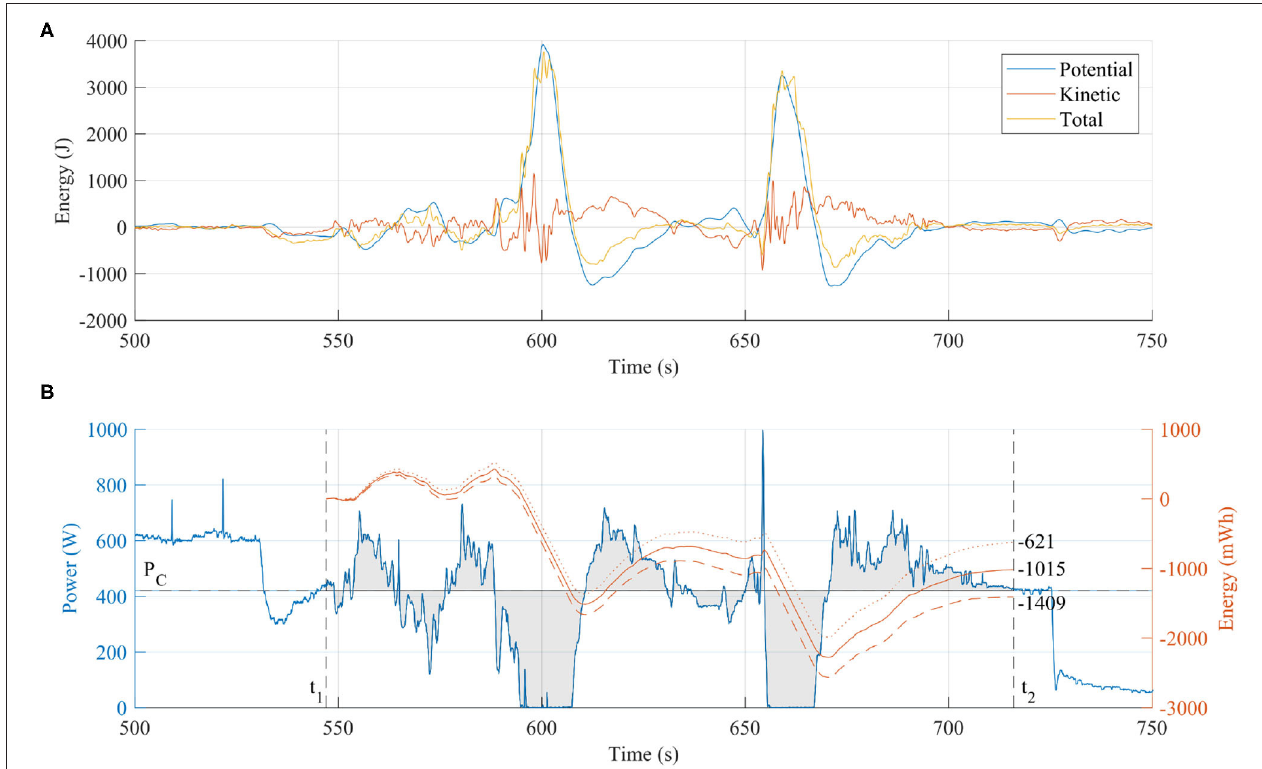
FIGURE 8 | (A) The kinetic and potential energy are almost equal before and after the plume transect because the autopilot corrected errors in speed and altitude. However, less electrical energy was consumed due to the plume updraft. (B) By integrating the power consumed during the plume transect period, we can calculate the battery energy “saved” in mWh. The effect of small variations ( ± 2 % ) in the nominal cruise power, P C , are shown by the dashed and dotted lines, respectively in (B) , which indicate the method is sensitive to this